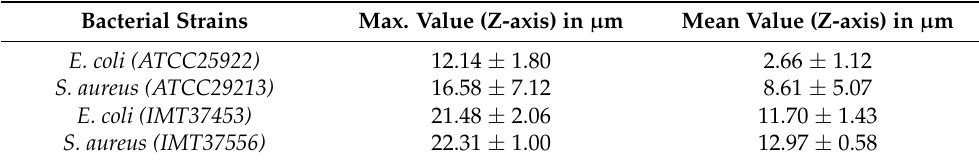
Figure 4. 3D model of four representative white light interferometry measurements. Results of the reference strains E. coli ATCC25922 ( a ) and S. aureus ATCC29213 ( b ) as well as the mastitis isolates E. coli IMT37453 ( c ) and S. aureus IMT37556 ( d ) are shown. The dimensions of the sensor membrane are represented by the x-axis and y-axis. The z-axis represents the maximum height of the biofilm. The color scheme (dynamic) shows the different heights of adhering bacteria in µm. Table 5. Representation of the z-axis detected after 24 h of incubation by white light interferometry measurement. Mean values, their standard deviations, and the maximum level of biofilm formation of n = 4 measurements (z-axis). The values are given in µ